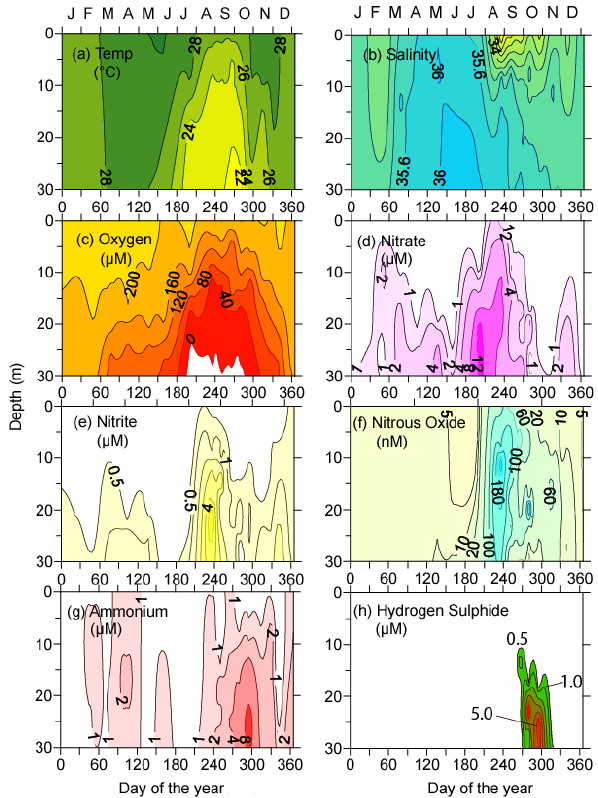
Fig. 4. Monthly-/fortnightly-averaged records showing annual cy- cle of (a) temperature, (b) salinity, (c) oxygen, (d–g) inorganic ni- trogen species, and (h) hydrogen sulphide at the Candolim Time Series (CaTS) site (15.52 ◦ N, 73.65 ◦ E) based on observations from 1997 to 2006. Modified from Naqvi et al. (2009).